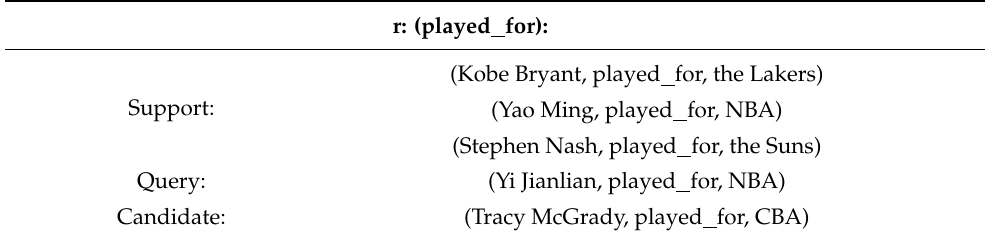
Table 1. An example of a 1-way 3-shot task in the